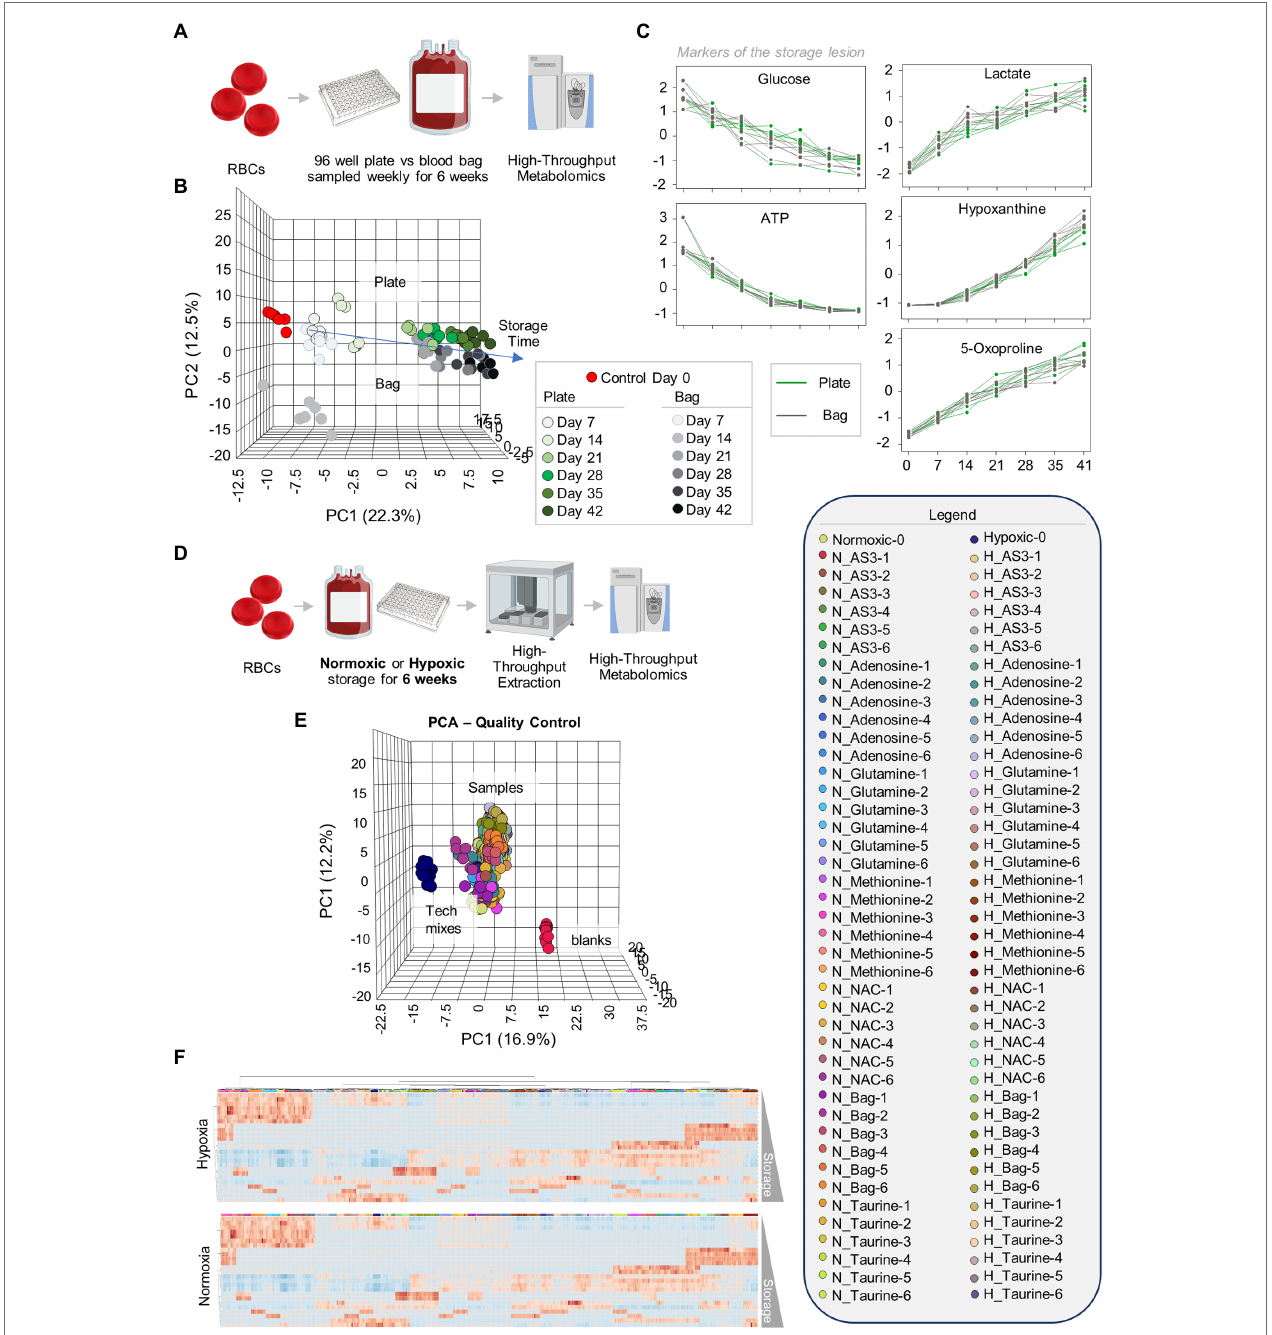
FIGURE 1 | Storage of red blood cells (RBCs) in 96-well plate is comparable to storage in a plastic bag. Leukocyte-filtered RBCs were collected from 12 healthy donors and placed either in a standard pediatric size diethylhexylphtalate (DEHP)-containing bag or in 96-well plate format, prior to storage under refrigerated conditions and weekly sampling for metabolomics (A) . (B) Similar metabolic phenotypes were observed for RBCs in either storage condition, with overlapping Principal Component Analysis (PCA) traces across component 1 (explaining 22.3% of the total variance) and only minor deviations at storage day 14 across principal component 3 (<5% of the total variance). Samples are color coded with shades of green (plate samples) and gray (bag) from lighter to darker as a function of storage time (B) . In (C) , line plots show trends for key metabolic markers of the storage lesion as a function of storage duration in the plate (green) or bag (gray). In (D) , the experiment in (A) was repeated by storing RBCs either in 96 well plates under normoxic (N) or hypoxic (H) conditions, in presence of five different supplements to AS-3 (untreated AS-3, adenosine, glutamine, methionine, N-acetylcysteine—NAC, and Taurine—color-coded in the legend in the right as a function of storage week 1 through 6) or in a small DEHP-supplemented pediatric bags containing AS-3. In (E) , PCA shows extreme reproducibility of tech mixes (blue) and blanks (red). In (F) , heat maps of hypoxic or normoxic RBCs stored in different additives (significant metabolites by two-way ANOVA are